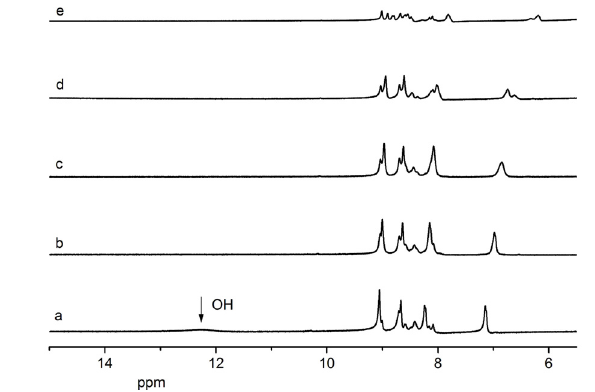
− : ( a ) free 1 ; ( b ) 1 + 0.5 equiv; ( c ) 1 +1.0 equiv; PO 2 4 N] H PO . 4 2 4